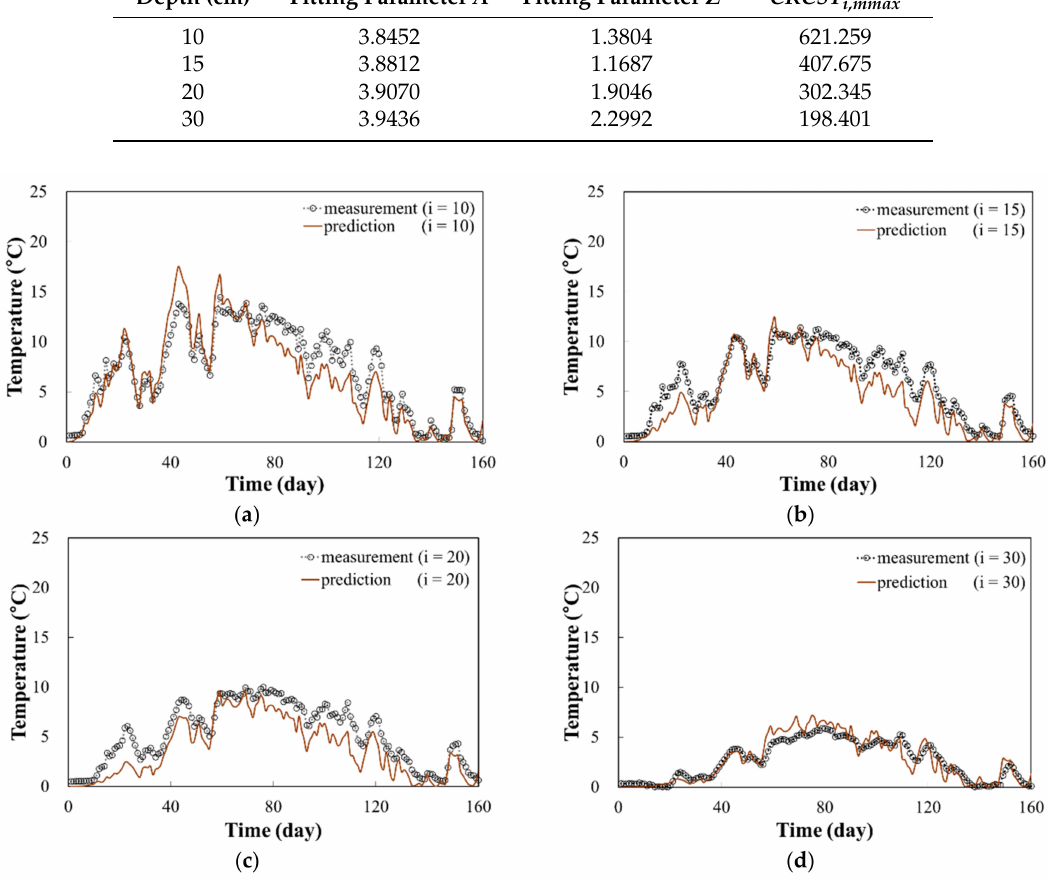
Figure 11. Measured and predicted temperature curves for additional data at depths of ( a ) 10 cm; ( b ) 15 cm; ( c ) 20 cm; and ( d ) 30